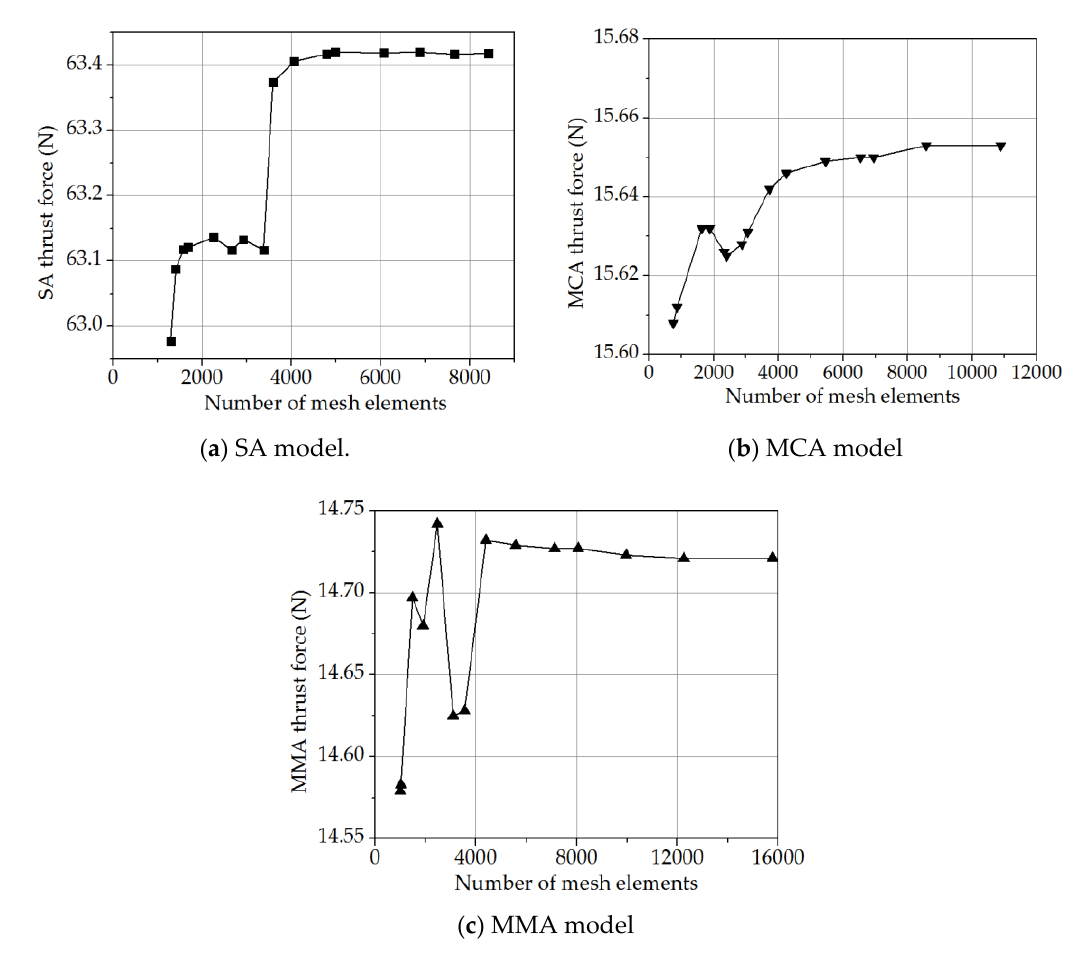
Figure 10. Thrust force convergence of modified models.